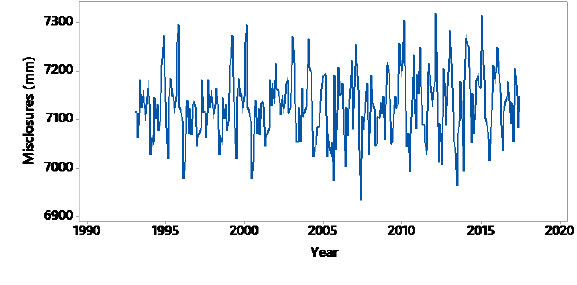
Fig. 6. RMSE=68.8 mm.